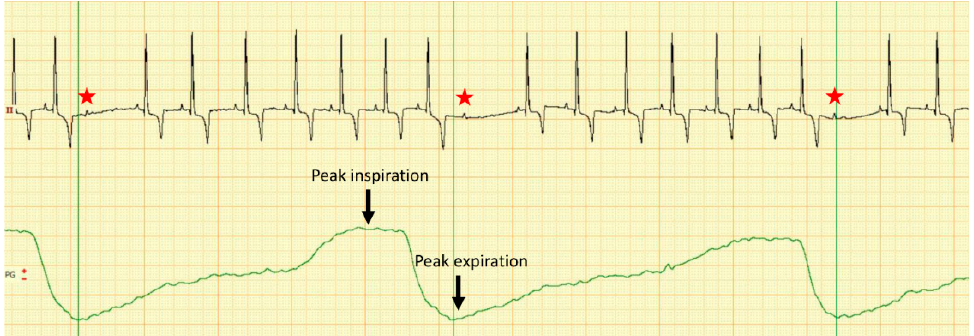
Figure 1. Dual channel recording of the electrocardiogram in lead II (upper line) and respiratory curve (lower green line) in a dog with severe azotemia. Note that there is a repetitive second-degree 2:1 AV block (red star) following each inspiration peak with a variable delay; calibration 10 mm/mV, 50 mm/sec.